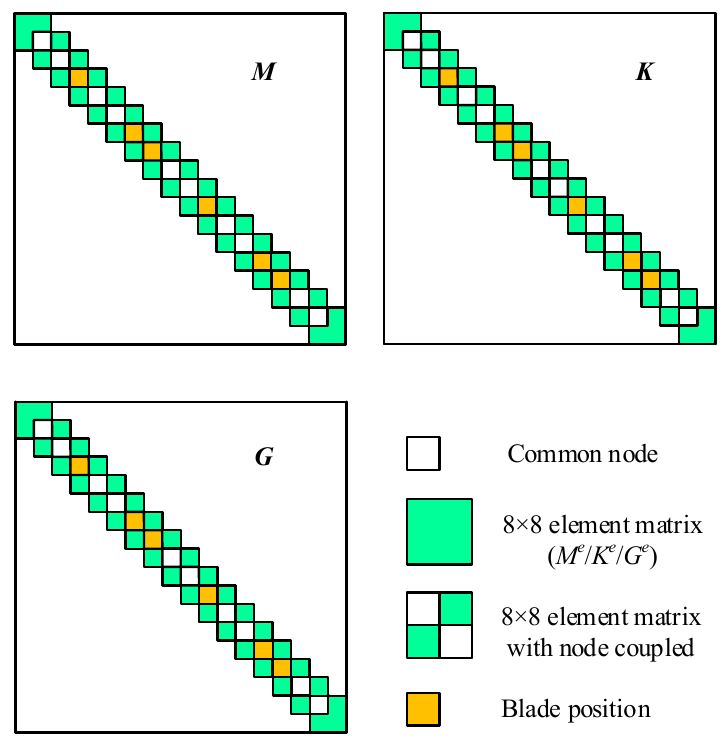
Figure 4. Assembly process for the total matrices after Guyan DOF reduction.